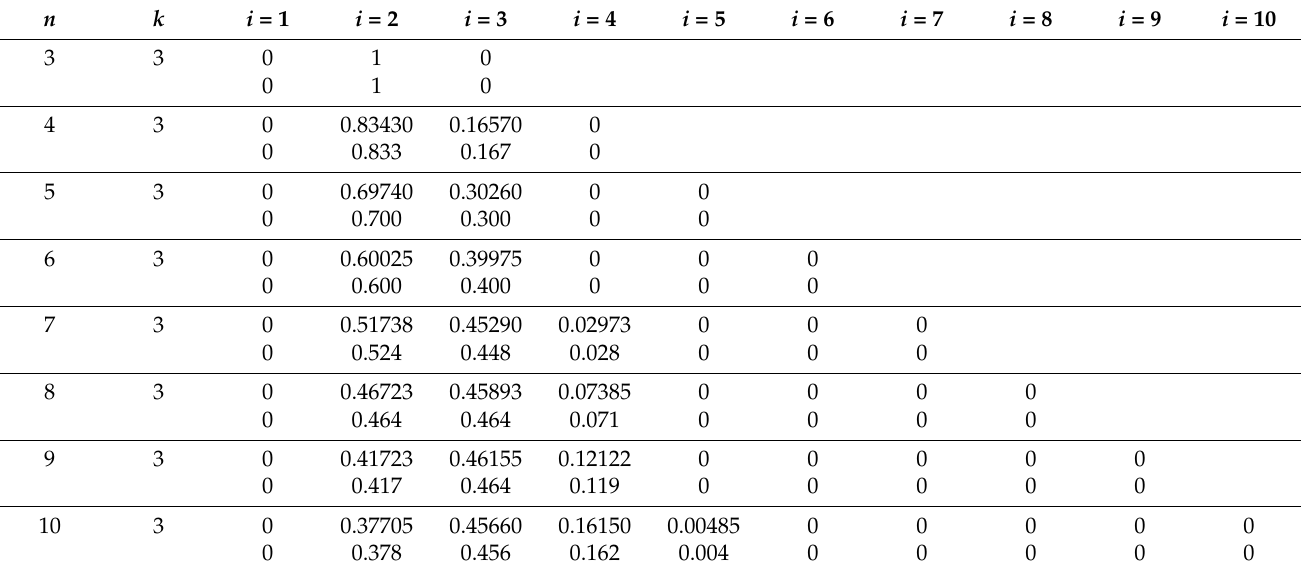
Table 2. Accurate and simulation-based signatures of the weighted-2-within-consecutive-3-out-of- n : F system for specific